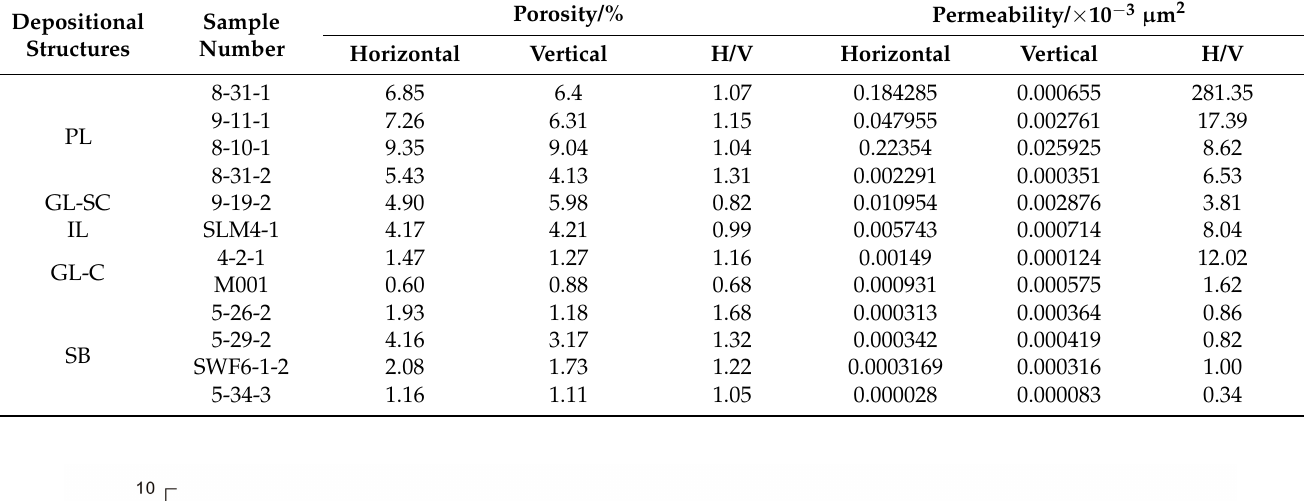
Table 2. Porosity and permeability of shale with various depositional structures from the Wufeng– Longmaxi shale in the Sichuan Basin of southwestern China.